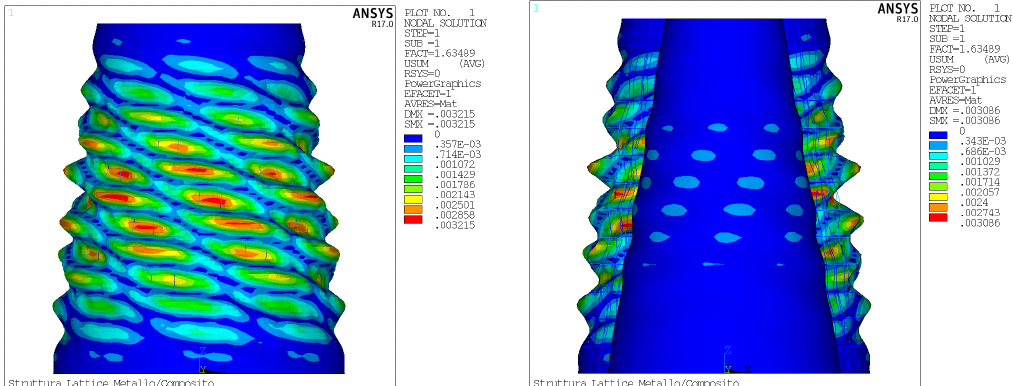
Figure 12. Test case 1—1st buckling mode—Total Displacement.